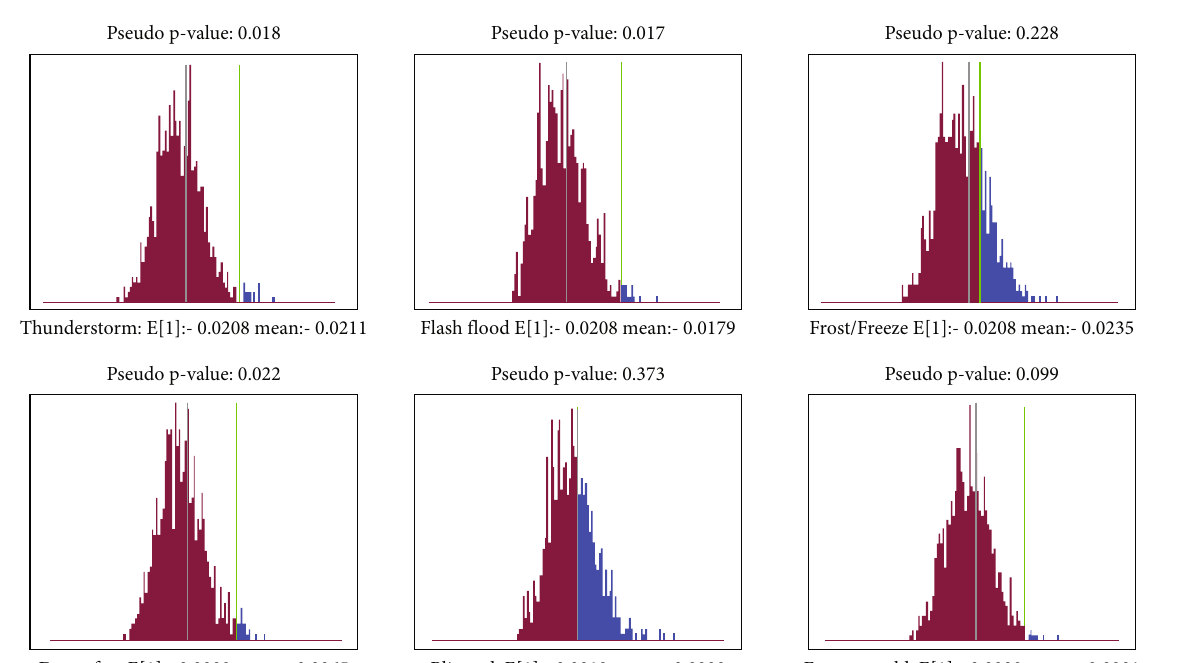
Figure 4: Test result of global Moran index after